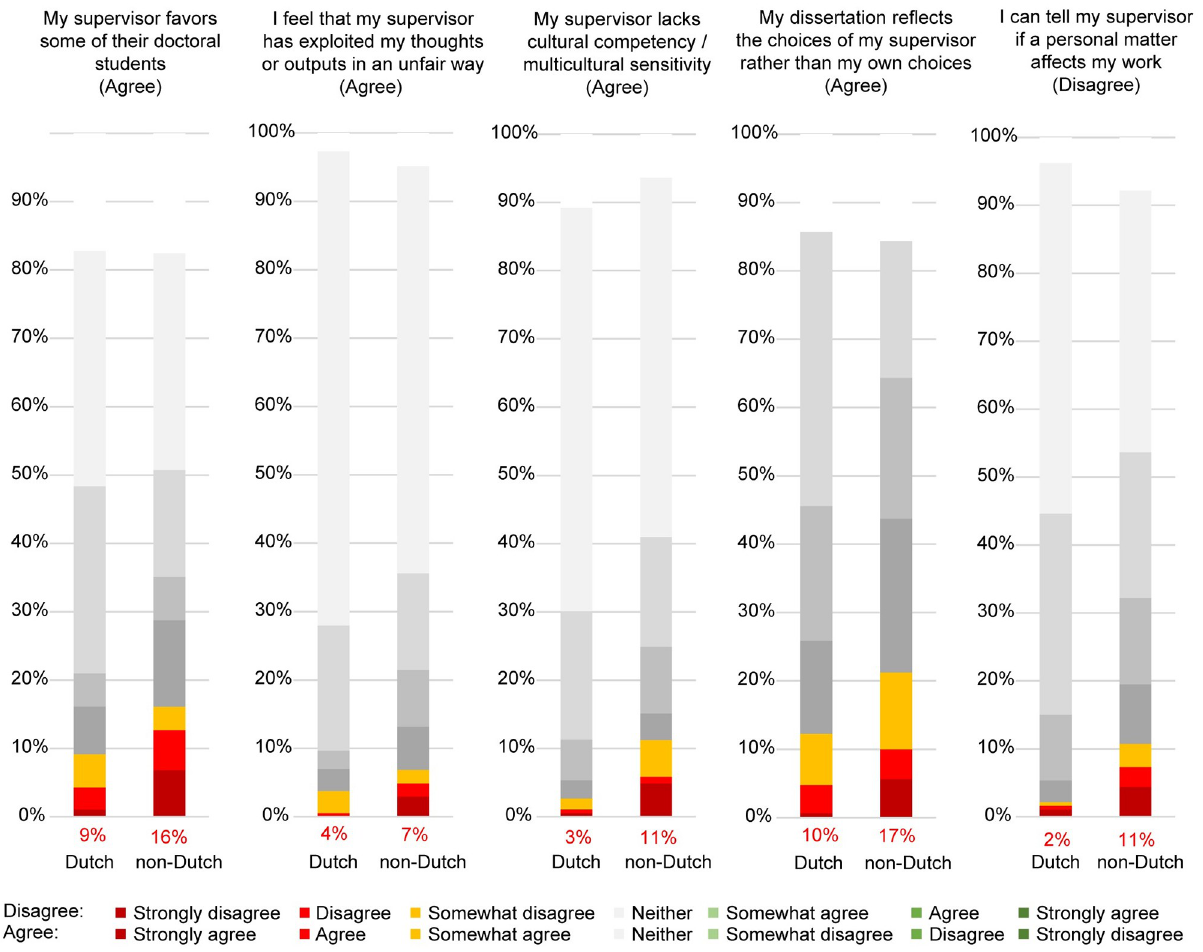
Fig 8. Dutch and non-Dutch PhD candidates’ characterization of their primary supervisor’s practices. Note : Scales range either from strongly disagree to strongly agree (marked “disagree”) or the opposite, strongly agree to strongly disagree (marked “agree”). Numbers in red represent the rate of respondents who at least “somewhat